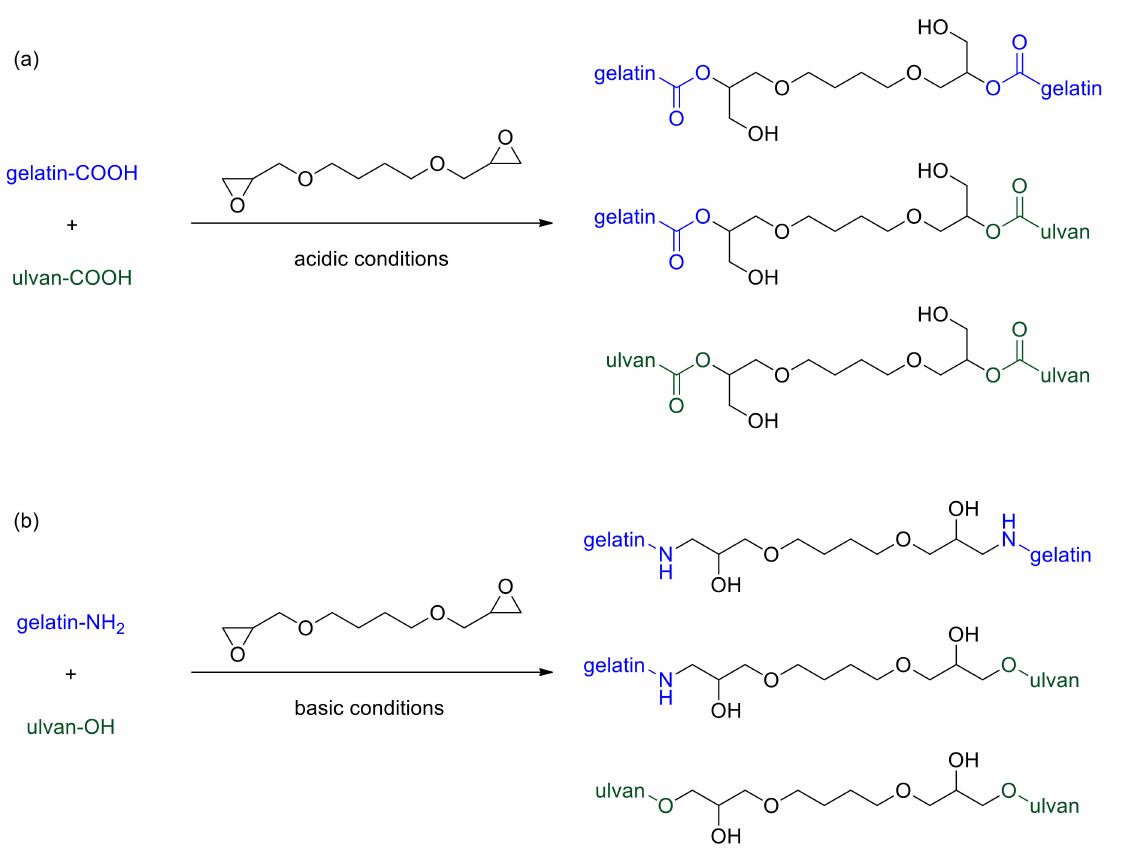
Figure 1. UG hybrid sca ff olds of di ff erent composition prepared under acidic and basic conditions. The amount of ulvan and gelatin used are reported as w / w